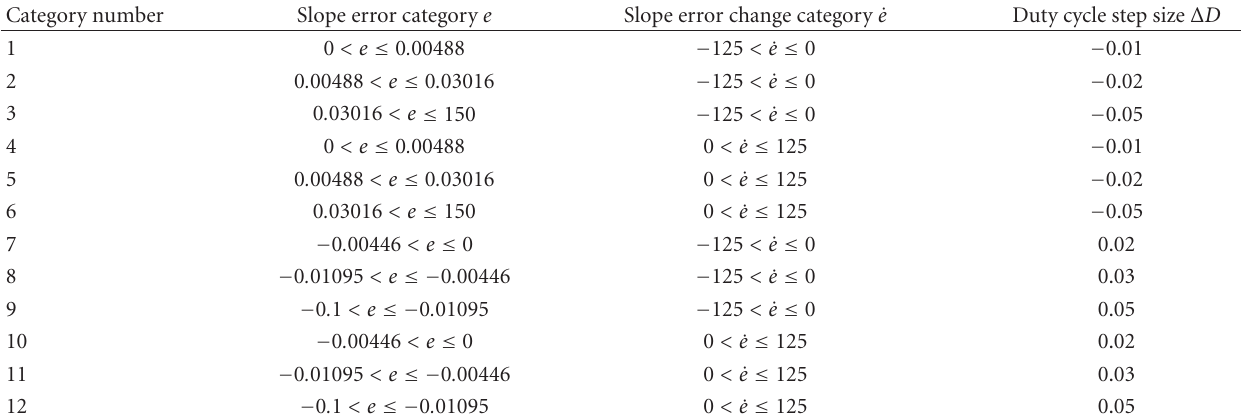
Table 1: Slope error e , change in slope error Δ e , and change in duty cycle Δ D of the 12 categories.